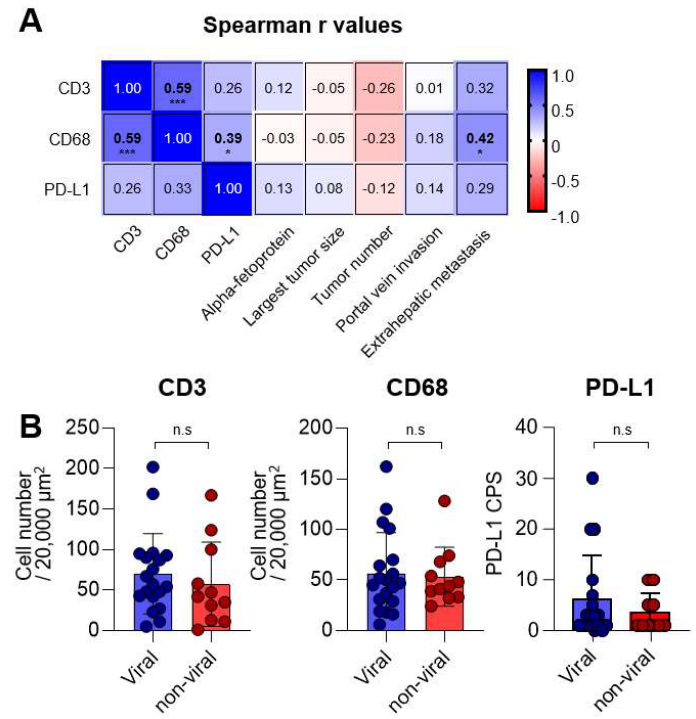
Figure 3. Correlations between CD3, CD68, programmed cell death-ligand-1 (PD-L1), and clinical parameters. ( A ) Matrix presenting the Spearman r values between each immunologic and clinical parameter. ( B ) Graphs showing the CD3+ and CD68+ cell numbers, as well as PD-L1 CPS, in MKI- treated patients with viral (n = 19) and non-viral (n = 11) etiologies. n.s., not significant; * p < 0.05; *** p <0.001.